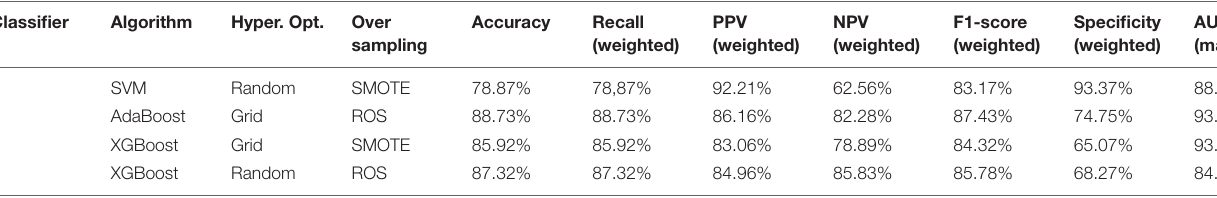
TABLE 6 | Superior performances in multiclass classification.